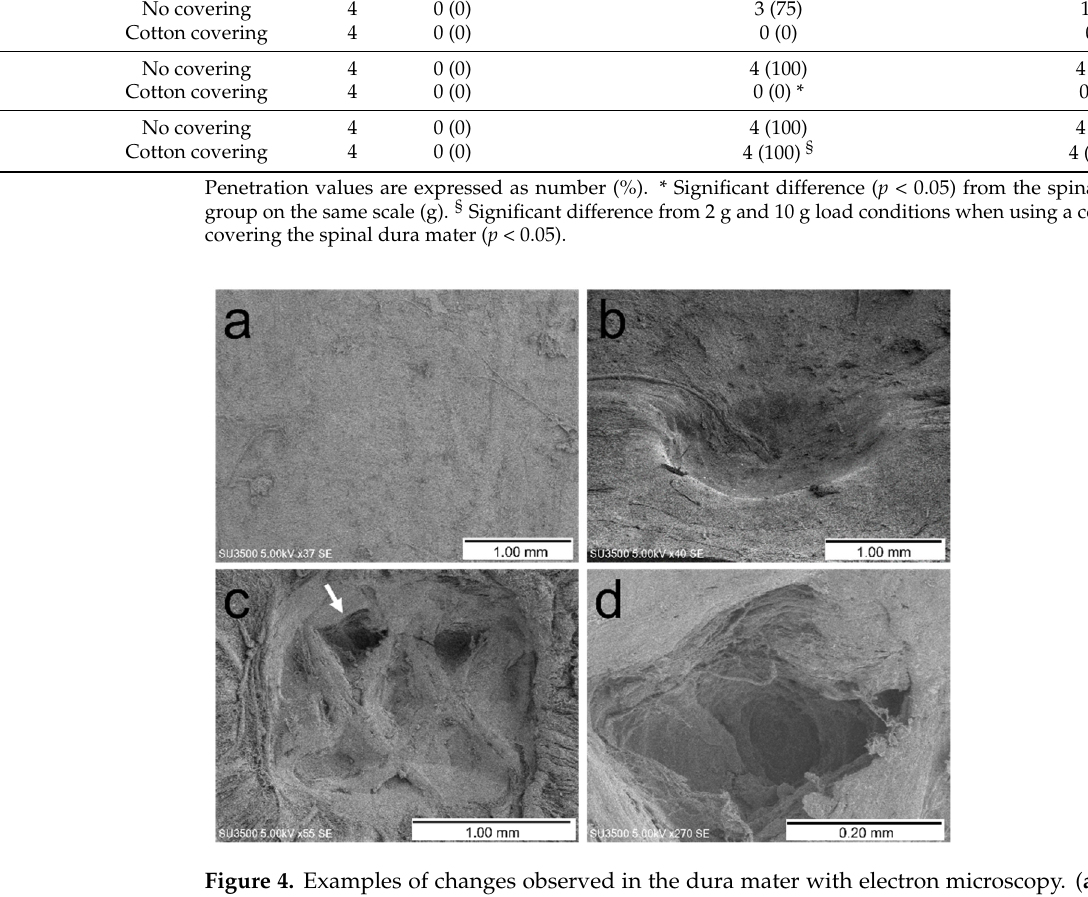
Figure 5. Examples of changes observed in the dura mater with stereomicroscopy. ( a ) Control. ( b ) Dural indentation and dark brown discoloration (arrowhead; 50 g load, no covering). ( c ) Dural in- dentation and dark brown discoloration (arrowhead; 50 g load, covered with a neurosurgical cotton pattie).